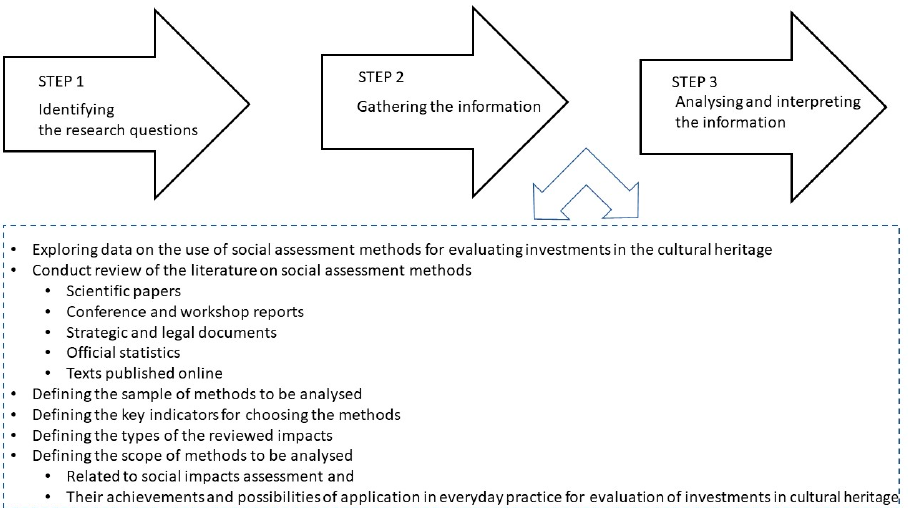
Figure 2. Main research steps. Source: Authors.